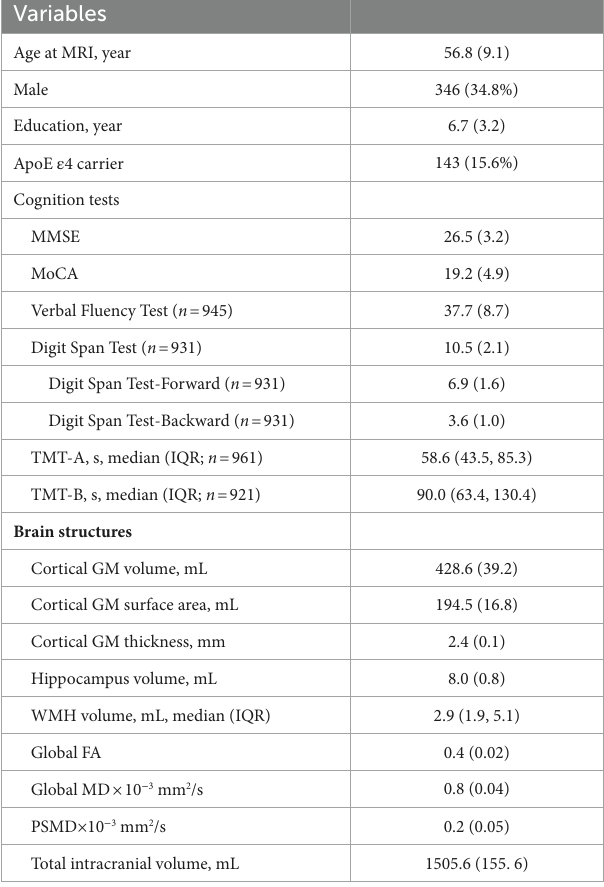
TABLE 1 Characteristics of the study population ( n =